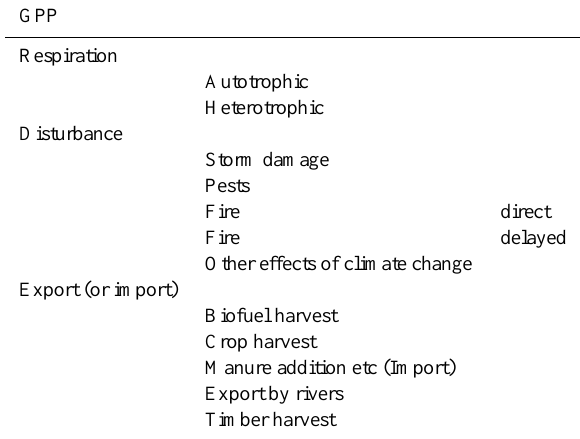
Table 1. Hierarchical decomposition of carbon cycle processes and fluxes acting at terrestrial ecosystem locations. Terrestrial sites can also have emissions from human and geological processes. Various observational and modelling approaches capture different groups of fluxes. Some of these carbon exchanges, particularly respiration and disturbance, need to be further partitioned between CO 2 and vari- ous forms of reduced carbon. The role of climate change in various forms of disturbance is an additional